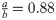
a) J-integral and load versus time curves for ab=0.88 of TW0/UD0-BC SHC beam with pre-existing skin crack and, the corresponding f(ab) versus a/b of the b) TW0/UD0-BC, c) TW0/UD0-TC and d) TW0/UD0-SC SHC beam.